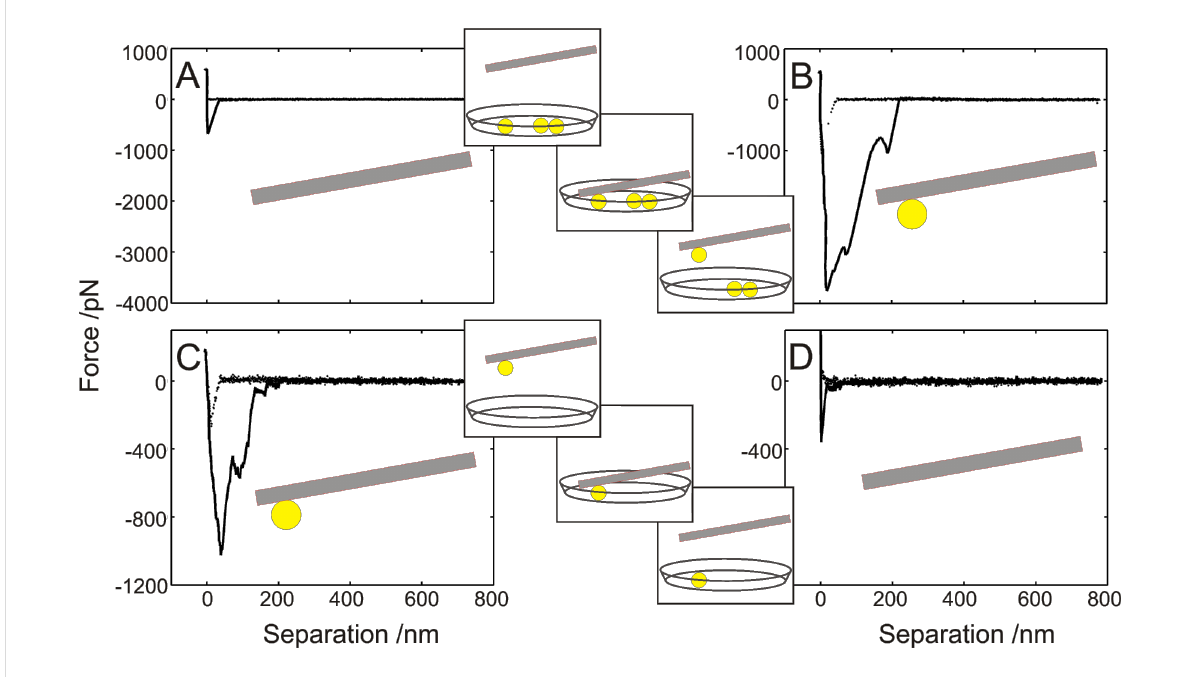
Figure 3: Test of artifacts of AFM force/distance curve with and without bacterium, each taken under the same conditions: (A) Bare (poly)dopamin- coated cantilever force/distance curve. (B) The same cantilever as in (A), yet after attachment of a bacterium. (C) A second cantilever with bacterium and its characteristic force/distance curve. (D) Force/distance curve after detaching the bacterium of the experiment shown in (C).